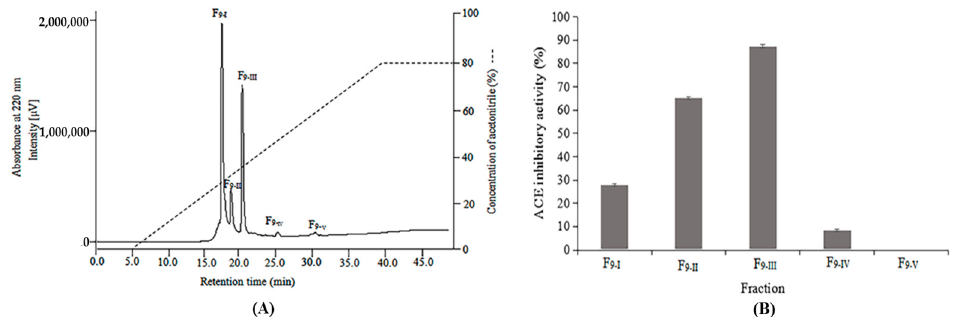
Figure 3. Purification profile of KSHPH-F 9 separated by RP-HPLC using a Mightysil RP-18 column ( A ). Peptide fraction was eluted by a linear gradient of acetonitrile (0~5 min, 100% A; 5~40 min, 100% A → 20% A/80% B; 40~50 min, 20% A/80% B.) at a flow rate of 0.5 mL/min. ACE inhibitory activity of each fraction (F 9-I –F 9-V ) was measured at a concentration of 0.5 mg/mL ( B ).